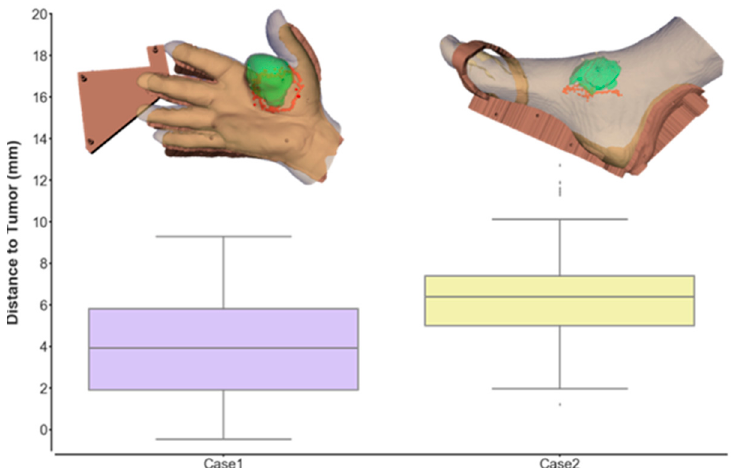
Figure 7. Image-guided surgery (IGS) during acral tumor resection surgery of case 1: ( a ) surgeons in the operating room (OR); ( b ) case 1 affected limb after tumor resection; ( c ) CT image; ( d ) AcralTumorNavigation software visualization of virtual 3D models. The red point in the CT image depicts the pointer tip. The green 3D model represents the tumor. All images are synchronized at the same moment of the surgery (Video S1).